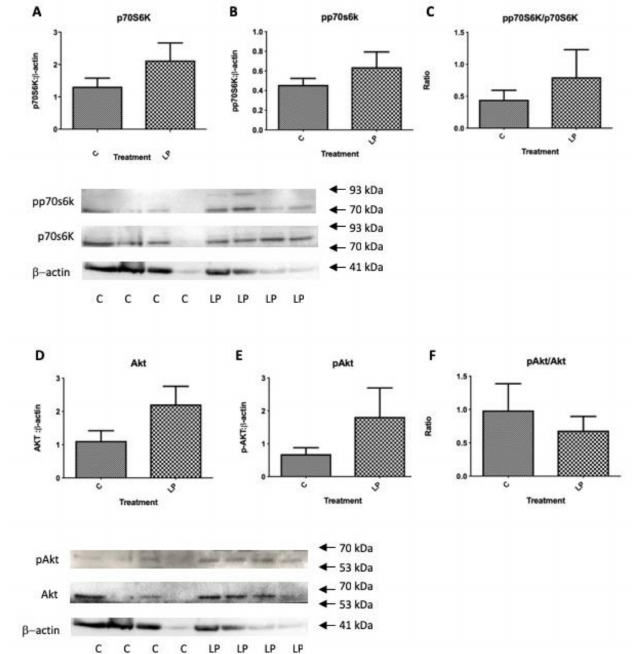
Figure 4. Changes in the abundance of total mTOR protein, phosphorylated mTOR and their ratio ( A – C ), and Raptor ( D ) in isolated islets from pancreata of 7-day old mice exposed in utero to control or LP diet relative to β -actin. Values show mean ± SEM; n = 4 per group, * p < 0.05, *** p < 0.001 vs. control diet. Confirmation of molecular weight was obtained relative to a standard protein molecular weight ladder (closest standards indicated by arrows).